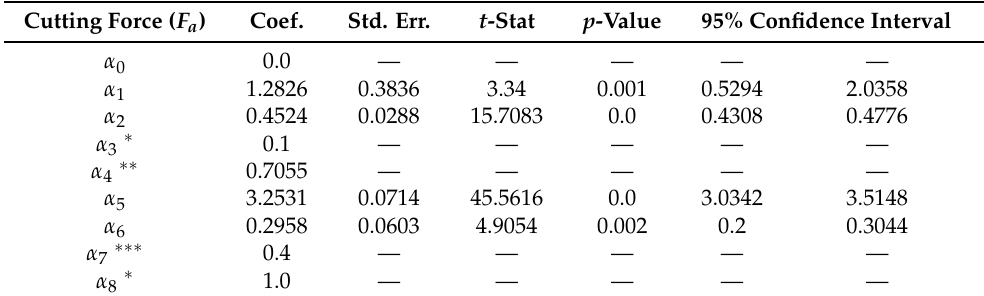
Table 9. Regression coefficients of normal force along with t -test and p values. Cutting Force ( F a )